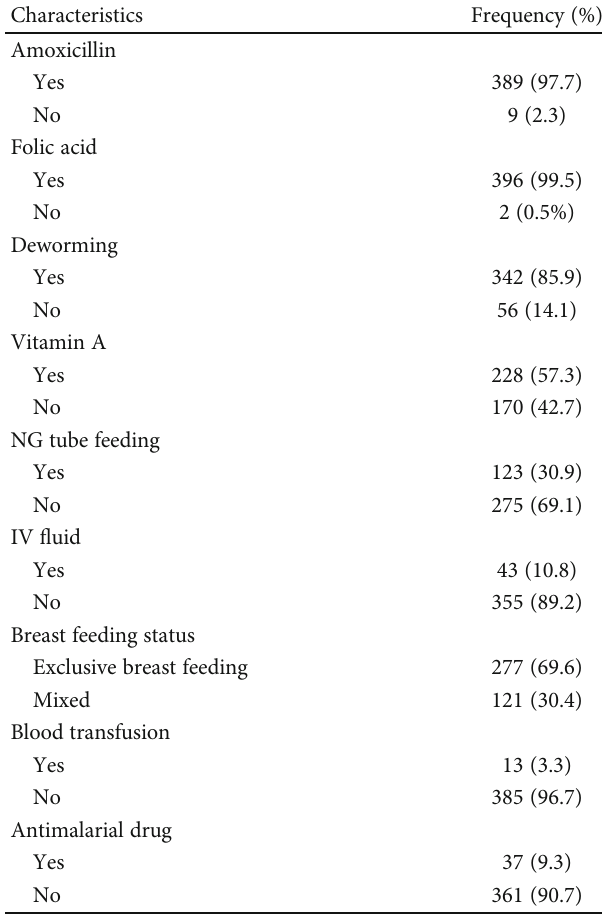
Table 3: Routine medication and supplementation for 6 – 59- month-old children with severe acute malnutrition in the therapeutic feeding center of Pawi General Hospital, northwest Ethiopia (2013-2017) ( n = 398